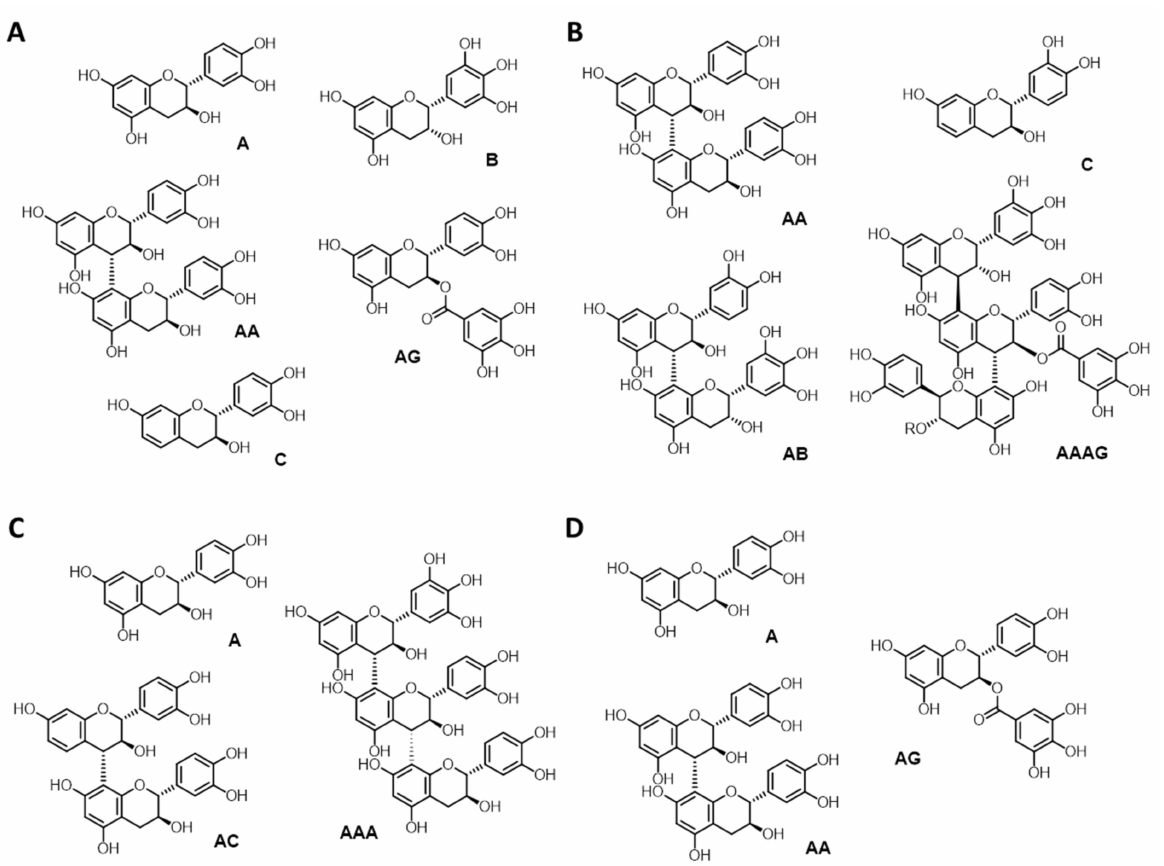
Figure 3. Representative examples of structural features identified on the basis of NMR and MALDI-ToF data in ( A ) Omnivin WG ( Vv ); ( B ) Omnivin R ( Vv -R ); ( C ) Omnivin 10R ( Vv -10 ); and ( D ) Omnivin 20R ( Vv -20